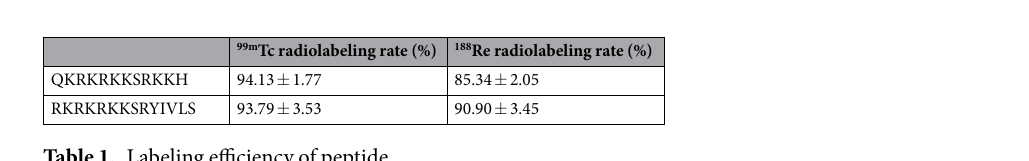
Table 1. Labeling efficiency of